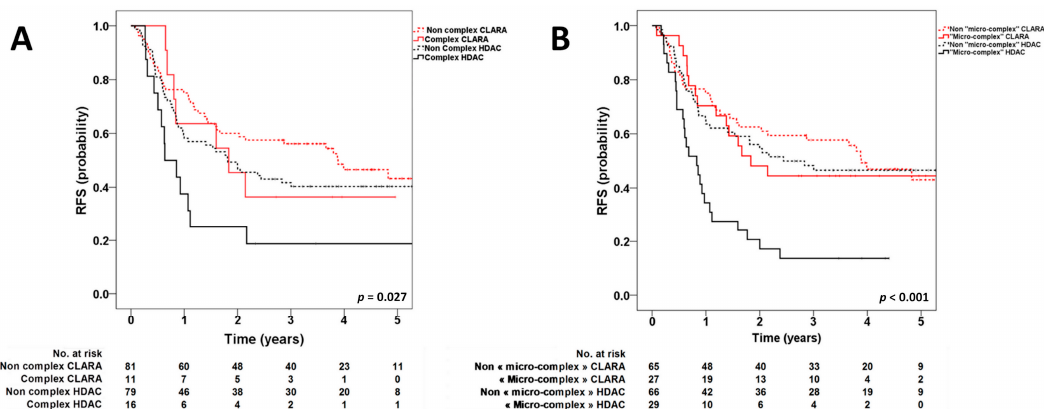
Figure 1. Kaplan–Meier estimates of relapse-free survival according to treatment arm (clofarabine-based consolidation (CLARA) vs. high-dose cytarabine (HDAC)) and complex karyotype ( A ) (4y-RFS: complex CLARA vs non-complex CLARA, p = 0.49; complex HDAC vs non-complex HDAC, p = 0.039; complex CLARA vs complex HDAC, p = 0.13; non-complex CLARA vs non-complex HDAC, p = 0.23) and micro-complex karyotype ( B ) (4y-RFS micro-complex CLARA vs non-micro-complex CLARA, p = 0.58; micro-complex HDAC vs non-micro-complex HDAC, p < 0.001; micro-complex CLARA vs micro-complex HDAC, p = 0.004; non-micro-complex CLARA vs non-micro-complex HDAC, p = 0.70).